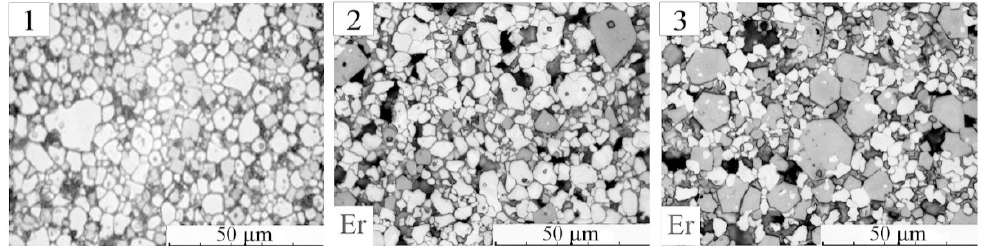
Figure 2. Pictures of the microstructures of ceramic Bi 1 − x Er x FeO 3 samples. ( 1 ) BiFeO 3 ; ( 2 ) x = 0.10; ( 3 ) x = 0.20.